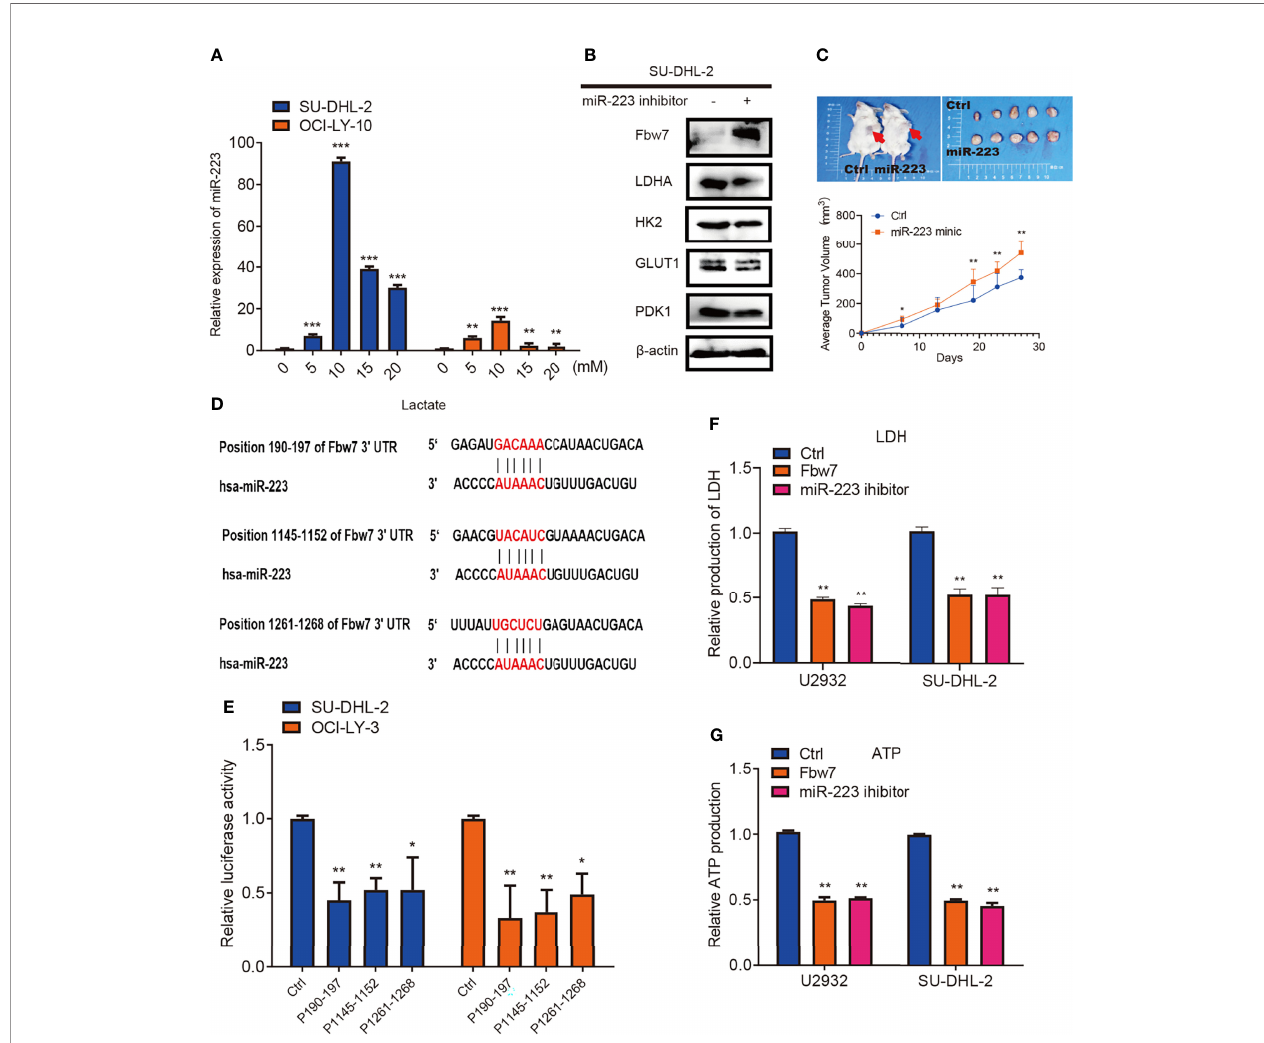
FIGURE 5 | miR-223 triggered by lactate targets Fbw7 and promoted DLBCL proliferation. (A) qPCR analysis of the relative miR-223 expression in SU-DHL-2 and OCI-LY-3 cell lines. Lactate was treated into cells with the indicated concentration gradient. The mean ± SD is shown for fi ve independent experiments. **P < 0.01. ***P < 0.001; one-way ANOVA. (B) western blots showed miR-223 inhibitor increases Fbw7 expression and mainly reduces LDHA expression in Glycolysis relative proteins. And the expression of Fbw7, LDHA, HK2, GLUT1, PDK1 were shown. (C) miR-223 mimic promotes SU-DHL-2 cell proliferation in vivo . Representative images of tumors proliferation in NOD-SCID mice. Mice were implanted with 1 × 10 7 cells into the fl anks of mice (n = 5). Here, mice were treated with miR-223 agomir and agomir of normal control twice a week. 27 days after tumor implantation, mice were sacri fi ced and tumor volume was measured. 1 cm for Scale bar. A multi-way classi fi cation analysis of variance tests was performed to assess data obtained from the tumor volume assays and data are shown as mean ± SD. P < 0.01. (D) binding sites of miR-223 and the 3 ’ -UTR of Fbw7 were shown for three conserved sites which was determined by the TargetScan algorithm. (E) reporter constructs containing a position of Fbw7 190-197 3 ’ -UTR region (wild-type, WT) or Fbw7 (MUT) with mutated miR-223 binding site of were co-transfected with a control oligo (mimic ctrl) or miR-223 mimic oligo into HEK293 cells. Luciferase activity was detected 24 hours after transfection. Data are shown as mean ± SD; n=5. *P < 0.01; **P < 0.01; one-way ANOVA. (F) Fbw7 and miR-223 inhibitor reduces intracellular LDH in U2932 and SU-DHL-2 cells. The mean ± SD is shown for fi ve independent experiments. **P < 0.01; one-way ANOVA. (G) Fbw7 and miR-223 inhibitor reduced ATP production in U2932 and SU-DHL-2 cells. The mean ± SD is shown for fi ve independent experiments. **P < 0.01; one-way